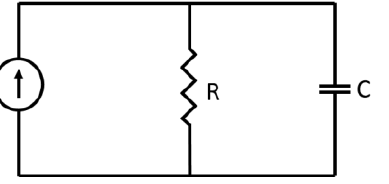
Figure 3. The electrical network model of the sensing junction.